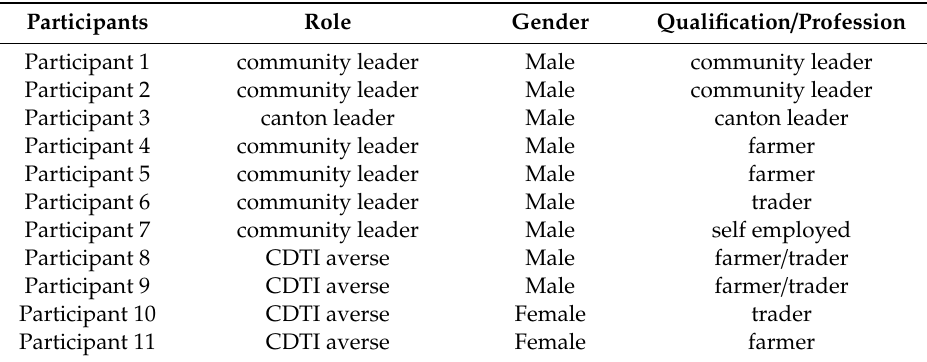
Table 2. Characteristics of the participants of individual